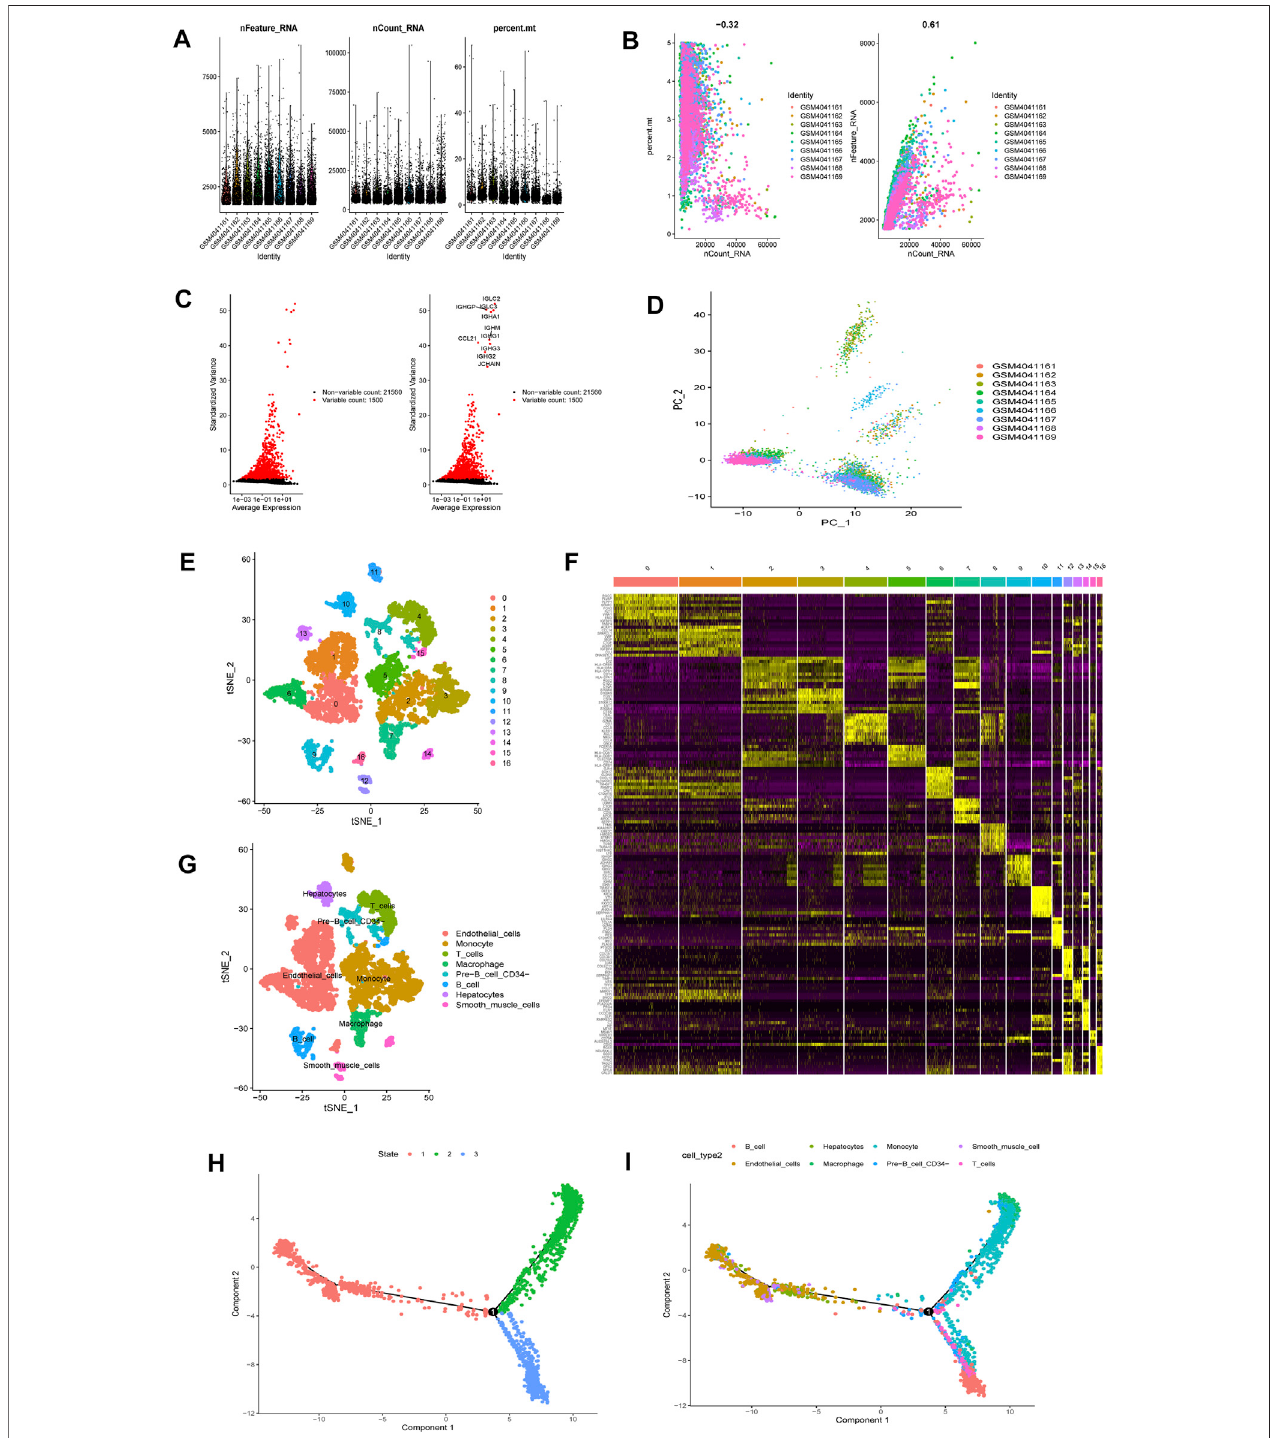
FIGURE 2 | scRNA-seq Data processing and analysis (A). Upon quality control and lognormalize normalization, 6,461 cells from nine liver cirrhosis samples remained (B). Correlation analysis: negative correlation between sequencing depth and mitochondrial gene sequences, and positive correlation between sequencing depth and the number of detected genes (C) . A total of 23,060 genes were included, 1,500 variable genes had high variation (D) . PCA based on scRNA-seq data (E) . 6,461 liver cirrhosis cells were classi fi ed into 17 clusters (F) . Expression analysis identi fi ed 4,171 marker genes and the top 10% visualized on a heatmap (G) . 17 clusters were annotated (H,I) . Pseudotime and cell trajectory